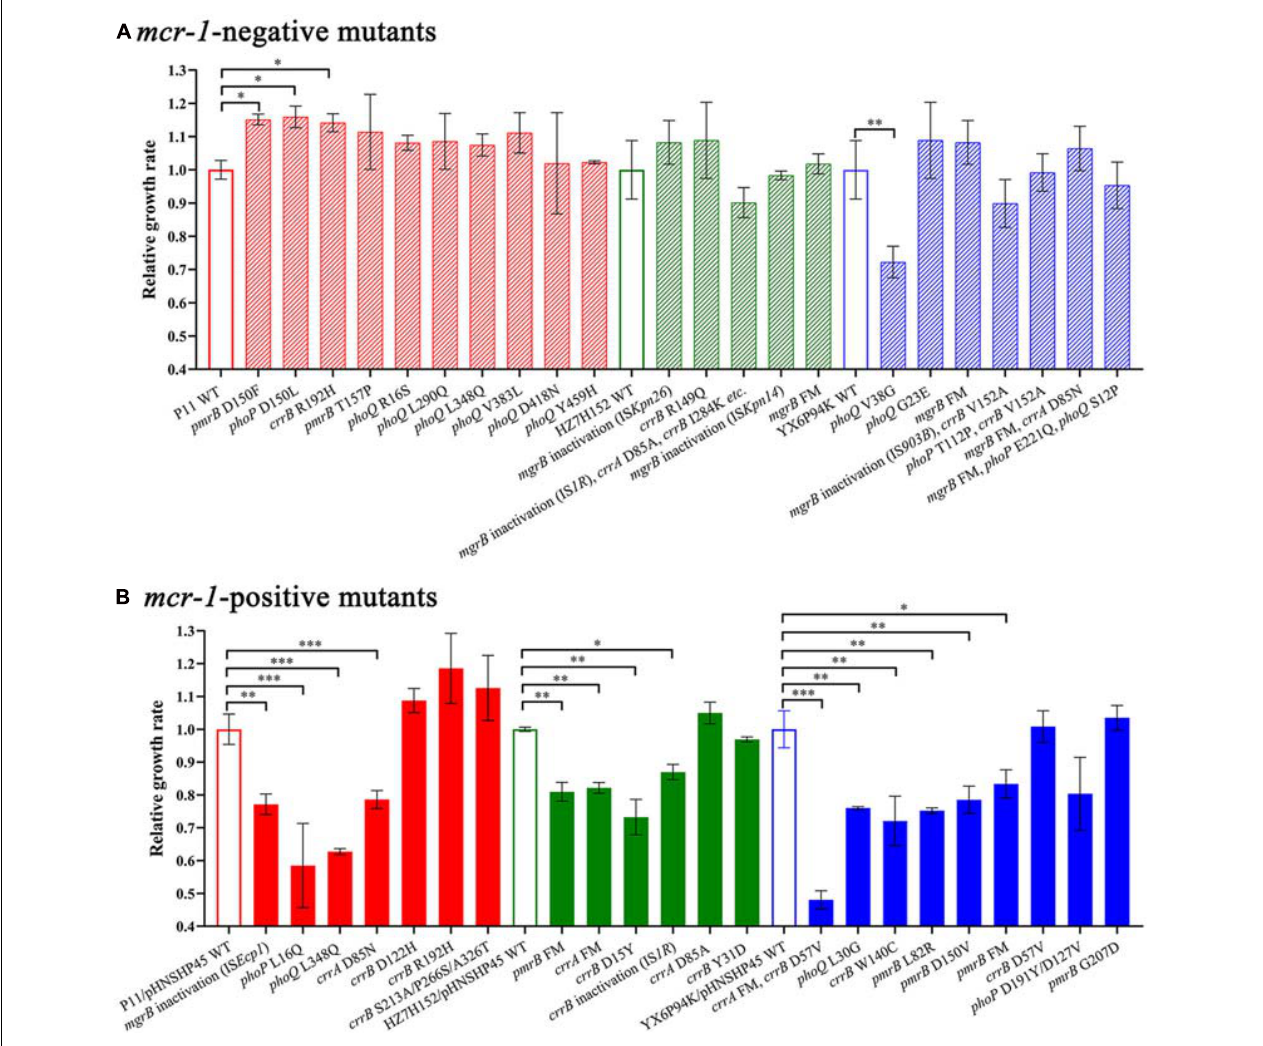
FIGURE 4 | Relative growth rates of mcr-1 -negative (A) and mcr-1 -positive (B) K. pneumoniae mutants and their parental strains. The maximal growth rates are presented as relative values compared with the wild-type growth rate (set to 1.0). The relevant mutated genes of each strain are indicated below the chart. ∗ p < 0.05; ∗∗ p < 0.01; ∗∗∗ p < 0.001. Error bars represent standard deviation values. WT, wild-type; FM, frameshift